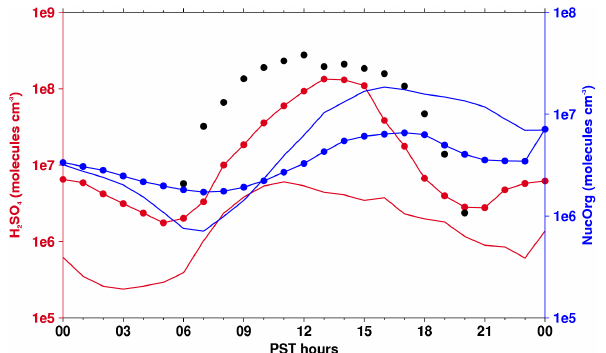
Figure 11. Modeled H 2 SO 4 (red lines), and NucOrg concentrations (blue lines) at the T0 site on 8 June 2010 (lines with circles) and 12 June 2010 (lines without circles). The black dots represent the calculated H 2 SO 4 proxy on 8 June 2010. The H 2 SO 4 proxy is not shown on 12 June 2010 due to missing measurements of SO 2